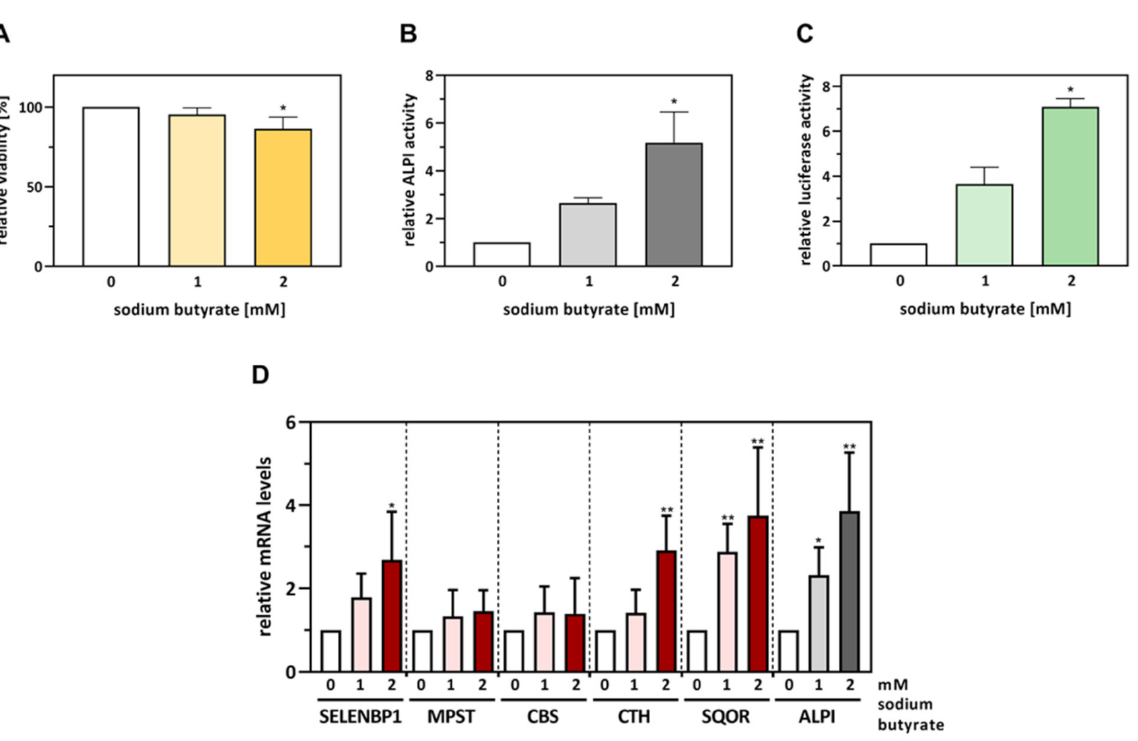
Figure 3. Butyrate increases SELENBP1 promoter activity and mRNA levels in parallel with the induction of differentiation in proliferating Caco-2 cells. The cells were cultured for one day and then incubated with sodium butyrate for 48 h at the indicated concentrations. ( A ) Cell viability was assessed by Neutral Red assay (untreated control set to 100%). ( B ) To monitor successful differentiation, enzymatic activity of ALPI was assessed photometrically in cell lysates. ( C ) Cells were co-transfected with hSELENBP1-luc and pRL-SV40 plasmids the day after seeding and then incubated with butyrate for another 48 h. SELENBP1 promoter activity was determined as relative luciferase activity (the untreated control was set as reference), with normalization against renilla luciferase activity. ( D ) Relative mRNA levels (with the untreated control set as the reference point) of the H 2 S-modulating enzymes and the differentiation marker ALPI in cells treated for 48 h with butyrate were determined as described in Figure 2. Three independent experiments were performed; the data represent means ± SD. Statistical analysis was done using the Friedman test and Dunn’s post-hoc test, with statistical significance at p < 0.05 (*) and p < 0.01